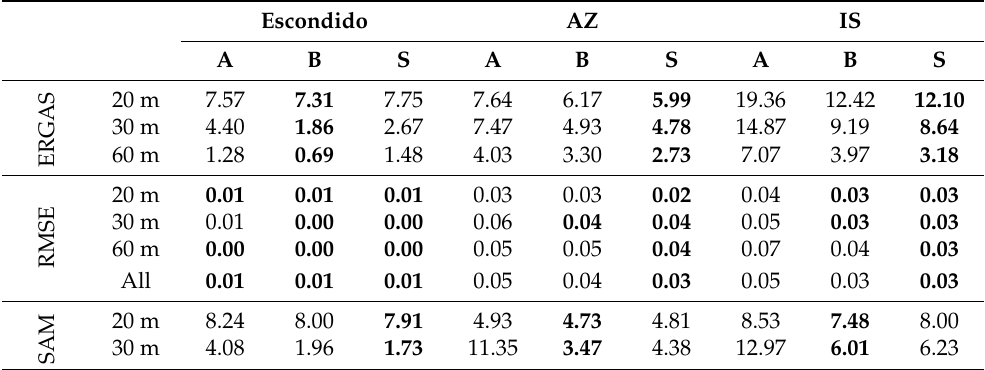
Table 1. The ERGAS, RMSE, and SAM values for the reduced scale images of IS, AZ, and the simulated image of Escondido. Lower values are better. The columns are labeled A for ATPRK, B for baseline, and S for SLSharp. The best results are shown in